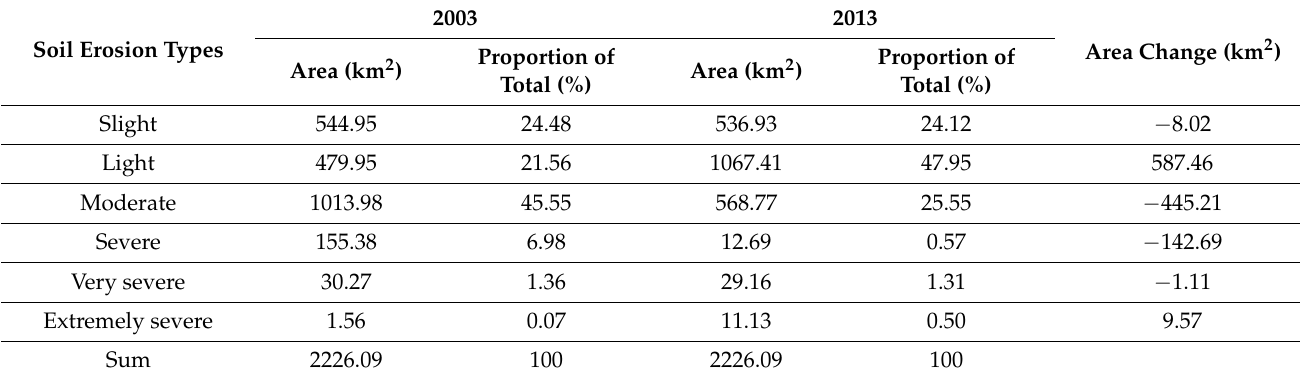
Table 6. Soil erosion changes from 2003 to 2013 in the study region.